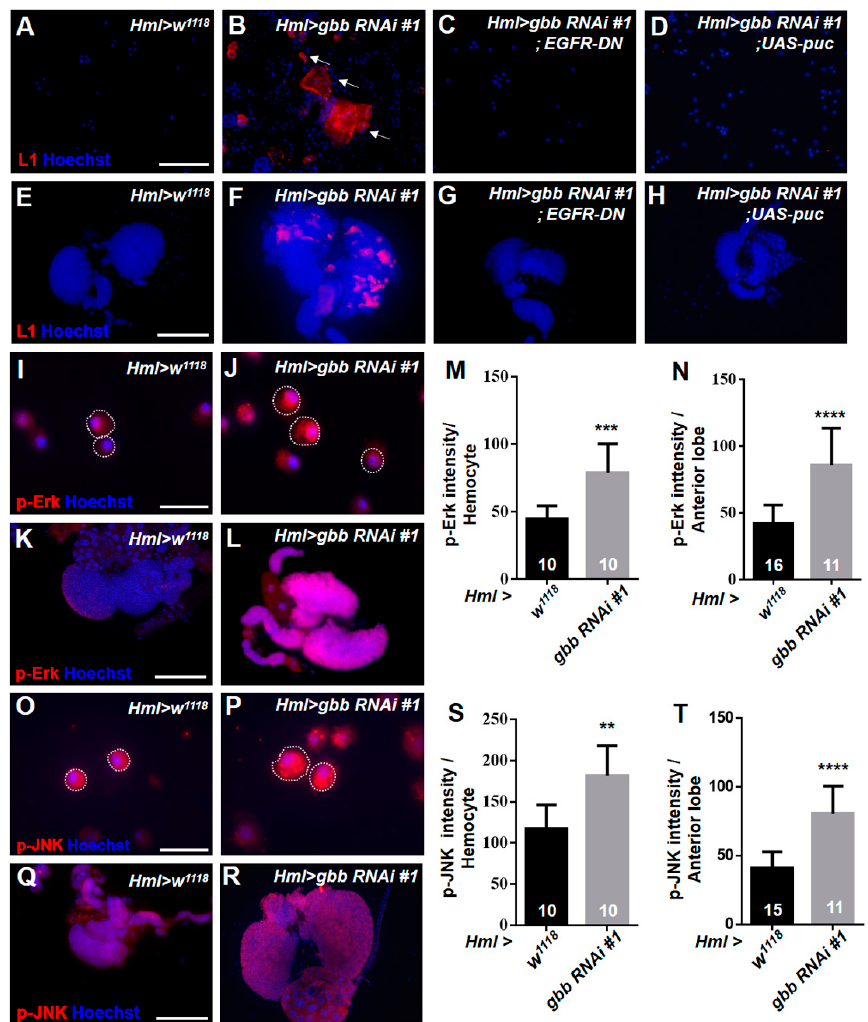
Figure 2. The knockdown of gbb in the CZ induces the differentiation of lamellocytes by activating the EGFR and JNK pathways. ( A – H ) Immunostaining against lamellocyte marker L1 in the circulating hemocytes ( A – D ) and lymph glands ( E – H ) of third-instar larvae. ( I – L ) The activity of the EGFR pathway was detected with anti-p-Erk antibodies. Immunostaining of circulating hemocytes ( I , J ) and lymph glands ( K , L ) showed high p-Erk (red) signals upon gbb knockdown. ( M , N ) Quantification of p-Erk intensity in circulating hemocytes ( M ) and lymph glands ( N ). In this and similar subsequent analyses, numbers of images of circulating hemocytes and numbers of lymph glands analyzed are indicated on histograms. ( O – R ) The activity of the JNK pathway was detected with anti-p-JNK antibodies. Immunostaining of circulating hemocytes ( O , P ) and lymph glands ( Q , R ) showed high p-JNK (red) signals upon gbb knockdown. ( S , T ) Quantification of p-JNK intensity in circulating hemocytes ( S ) and lymph glands ( T ). The arrows in B indicate the lamellocytes. Dashed white lines in ( I , J , O , P ) outline the edges of circulating hemocytes. For all quantifications: ** p < 0.01; *** p < 0.001; **** p < 0.0001 (Student’s t test). Scale bars: 50 µ m ( A – D ), 100 µ m ( E – H , K , L , Q , R ), 20 µ m ( I , J , O , P